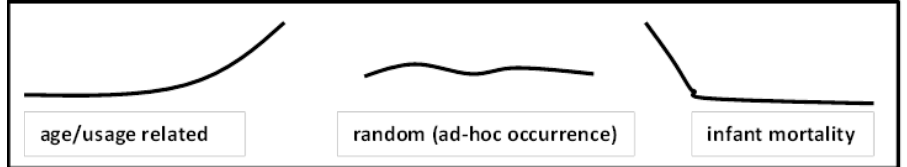
Figure 1. Failure History Pattern.